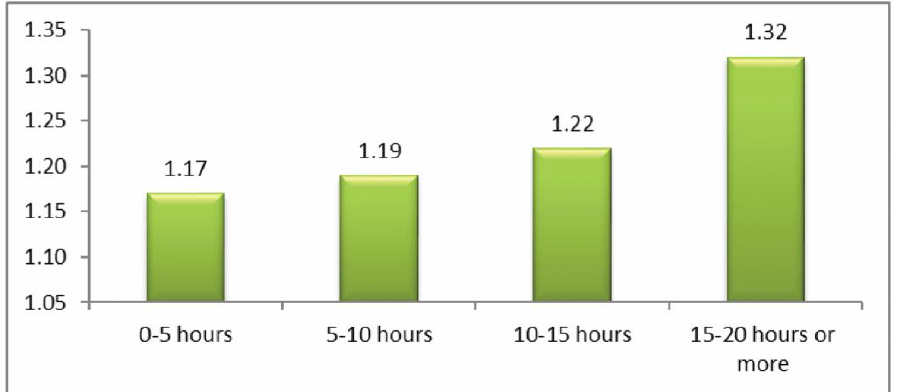
Figure 2. The risk of being a cybervictim (4-point scale), by time spent per week on the internet for the adolescents who used the internet ( n = 1140). Int. J. Environ. Res. Public Health 2020 , 17 , x